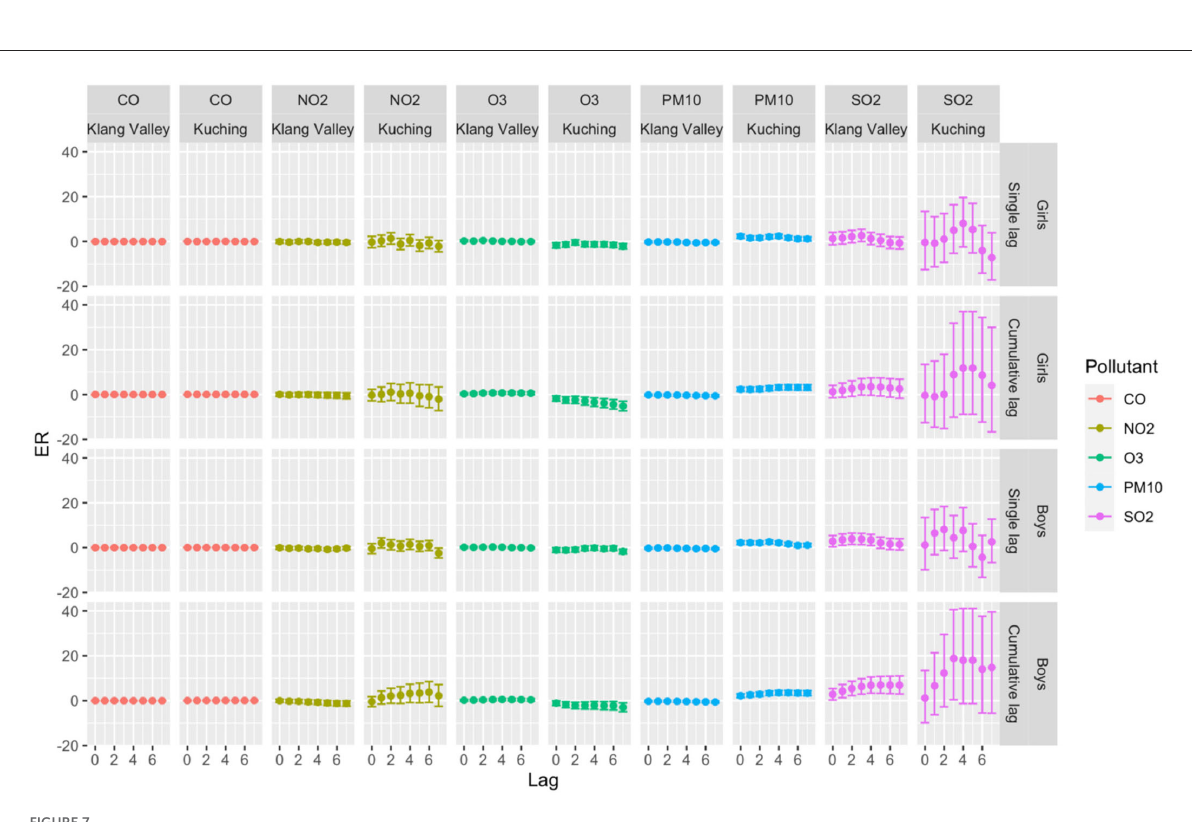
FIGURE7 ER with 95% CI of total daily hospital admission by gender with 10 µ g/m 3 increase of pollutant concentrations in Klang Valley and Kuching for